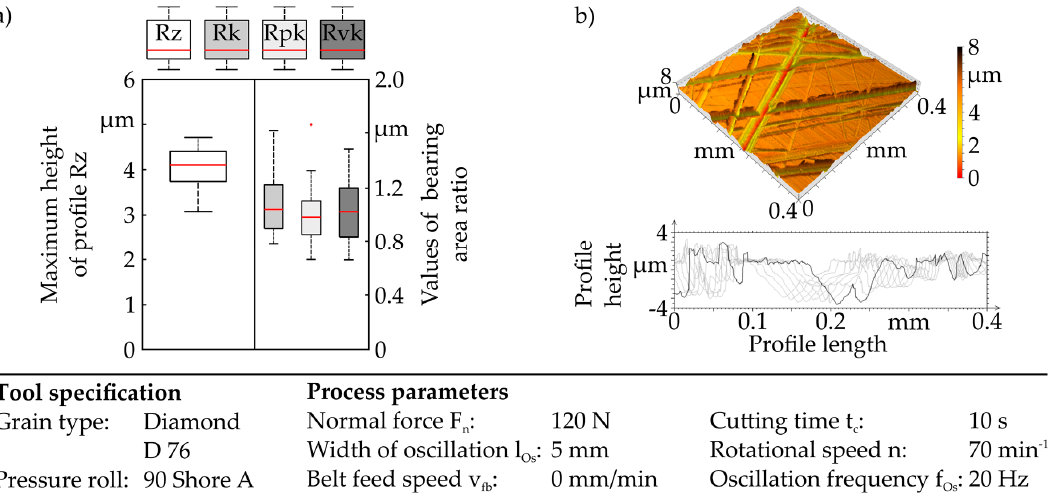
Figure 5. Initial surface structure. ( a ) Roughness parameters; ( b ) surface topography and profile serie.